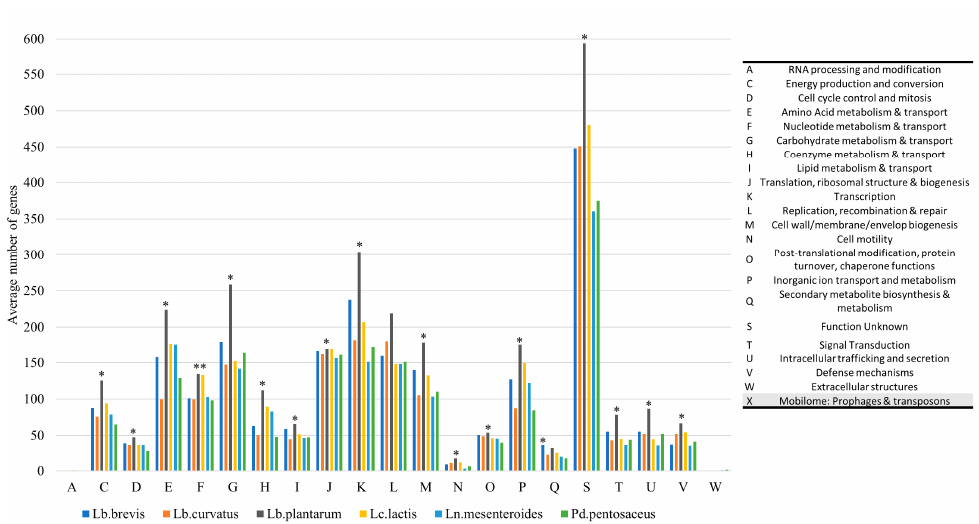
Figure 1. Bar chart plot showing the average number of genes per COG category for each LAB species. Abbreviation symbols for COG categories are according to the legend on the right. Species’ bars annotated with an asterisk indicate that the COG category was significantly more enriched for that species compared to all other LAB species. No genes belonging to the COG category “Mobilome: Prophages & Transposons” were identified in the isolates of our collection.